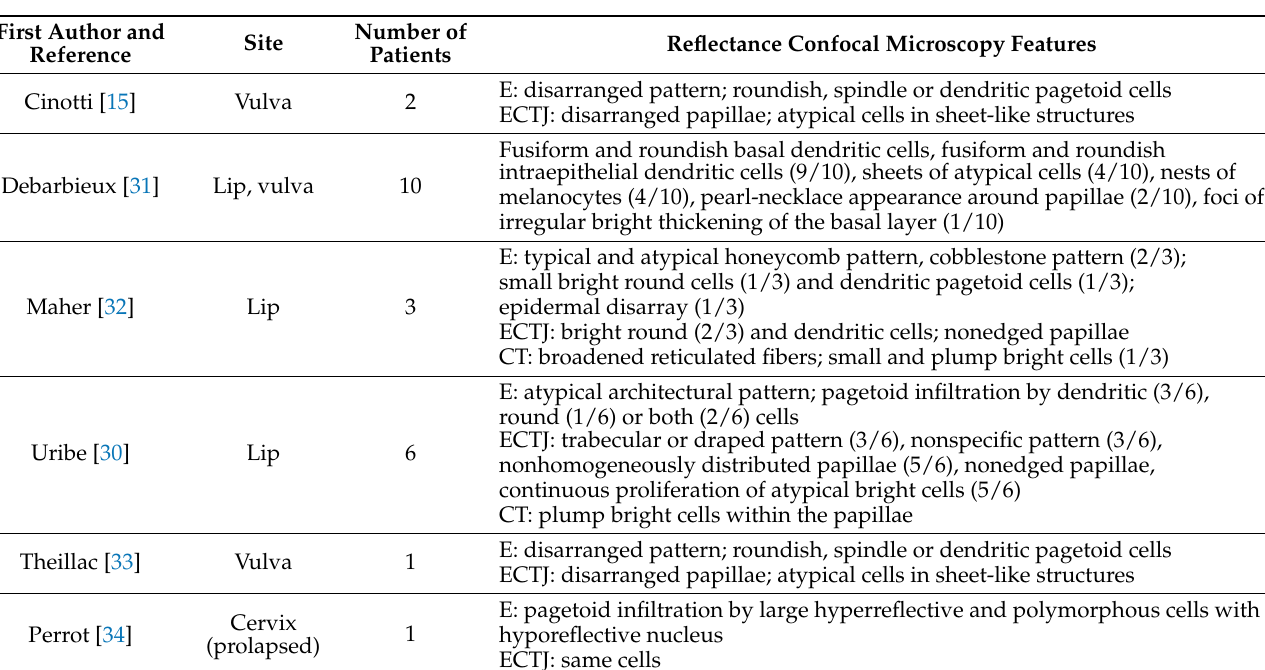
Table 2. Reflectance confocal microscopy features of the mucosal melanomas reported in the